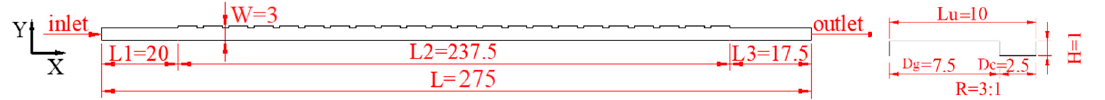
Figure 3. Detailed diagram of the tank and narrow channel.